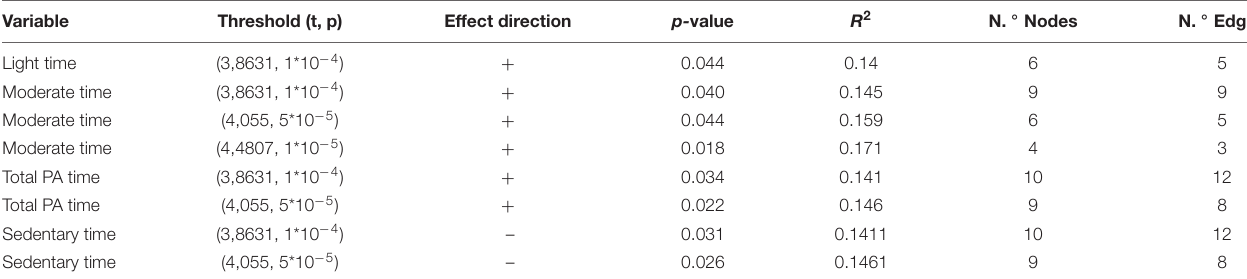
TABLE 7 | Results of the functional connectomics analysis using NBS ( n =